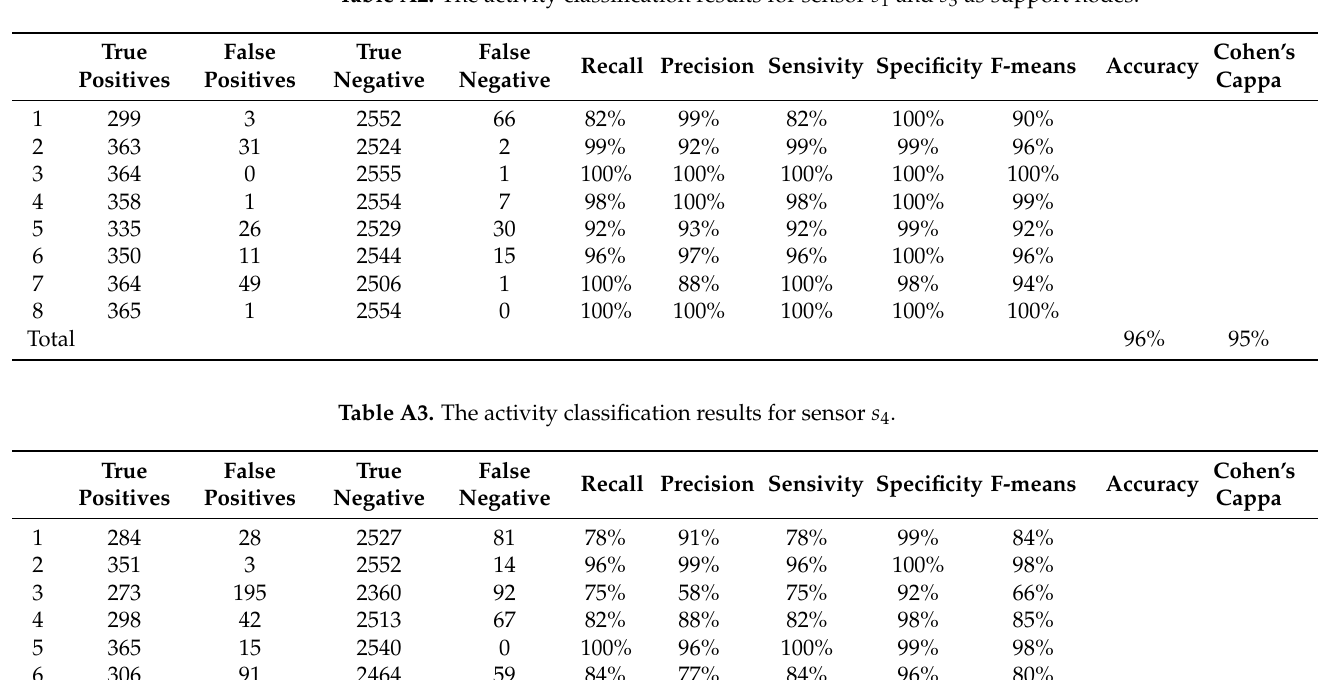
Table A2. The activity classification results for sensor s 1 and s 3 as support nodes.